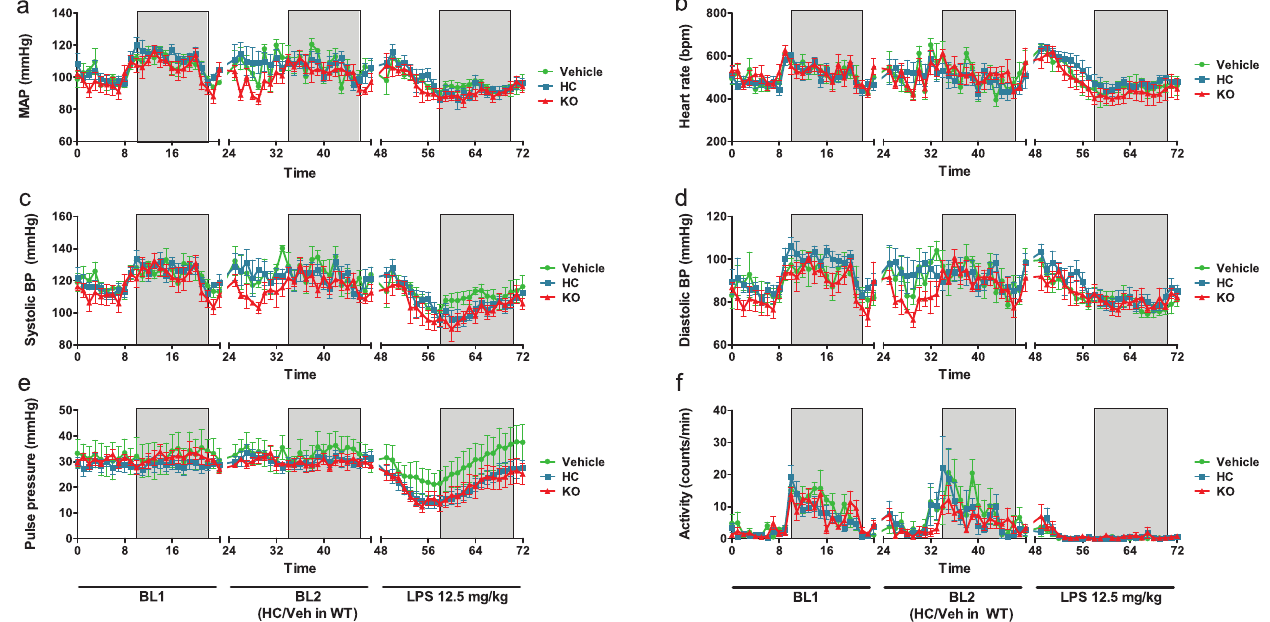
Figure 3. Haemodynamic monitoring in TRPV4 WT and KO mice under basal and endotoxaemic conditions. ( a ) Mean arterial pressure, ( b ) heart rate, ( c ) systolic pressure, ( d ) diastolic pressure, ( e ) pulse pressure and ( f ) locomotor activity at baseline (BL1), following systemic treatment (WT mice only) with HC-067047 (HC) or vehicle (10% DMSO) (BL2) and after induction of endotoxaemia (at time 48 h: LPS, 12.5 mg/kg, i.v.). Boxed regions denote periods of darkness. Data were acquired by radiotelemetry in conscious, ambulatory male C57BL/6 mice, and are presented as mean ± SEM, n =